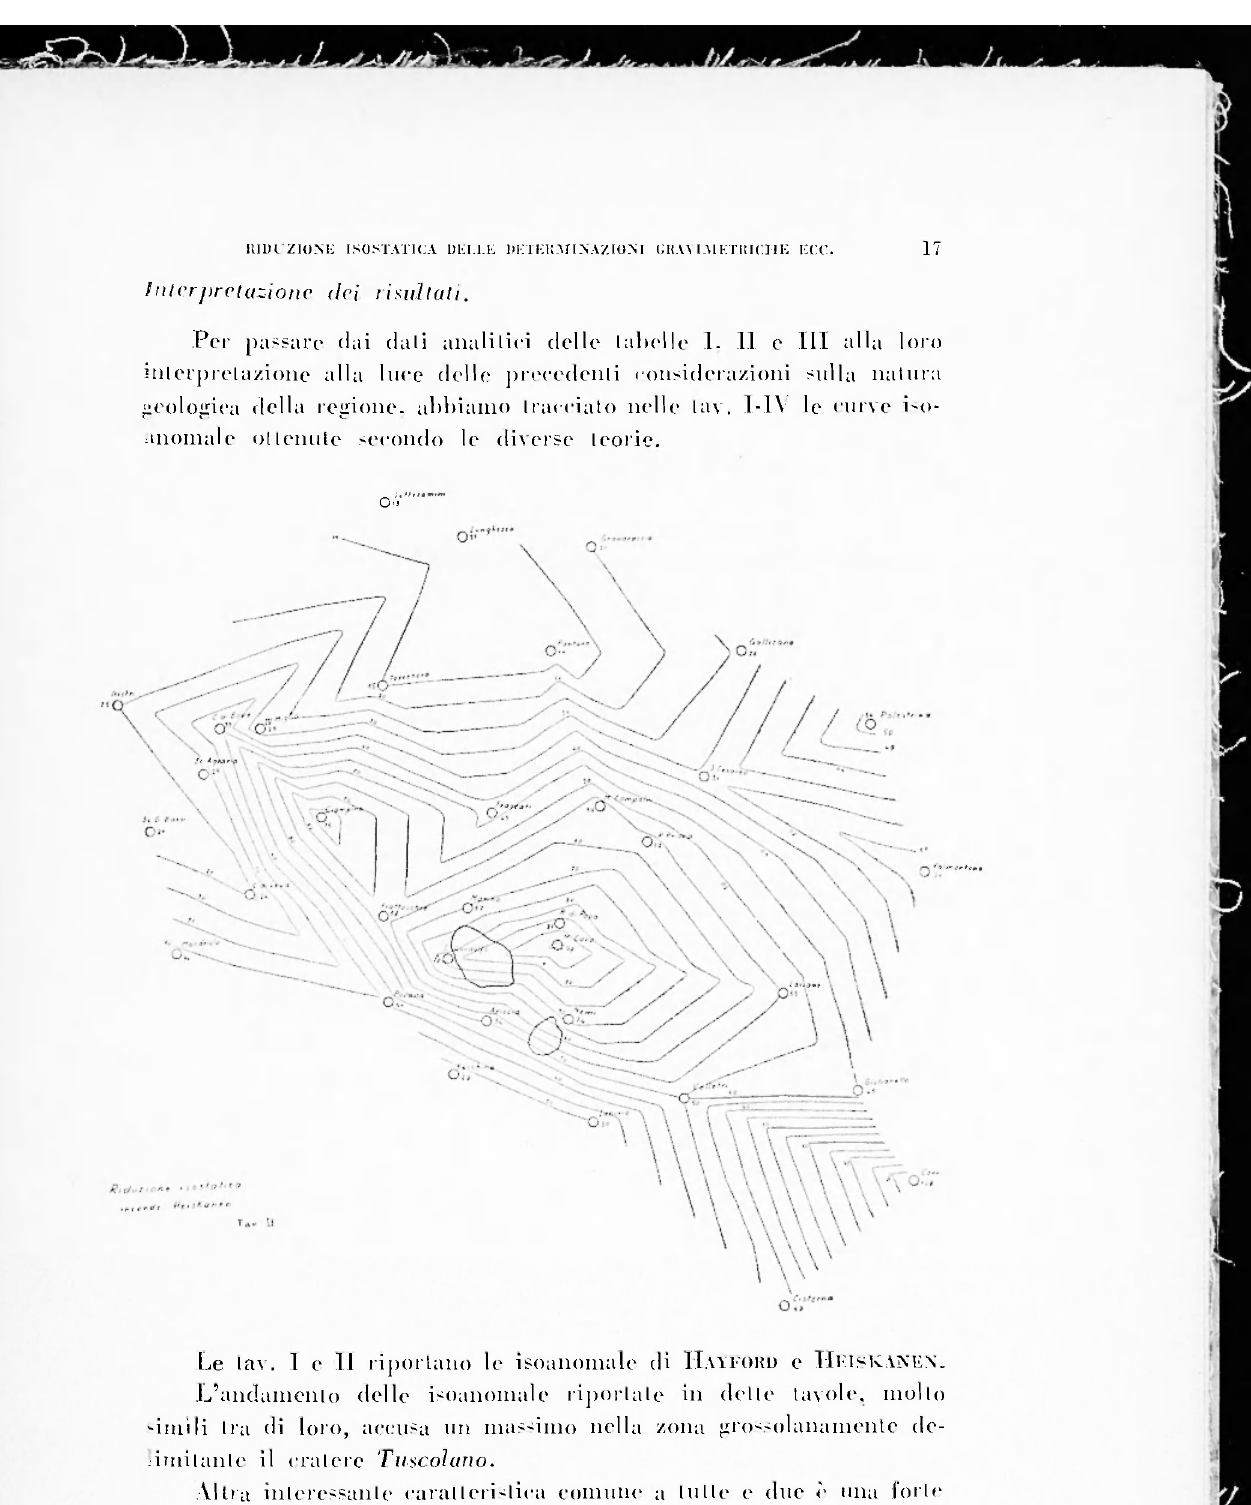
L'andamento delle isoanomale riportate in dette tavole,